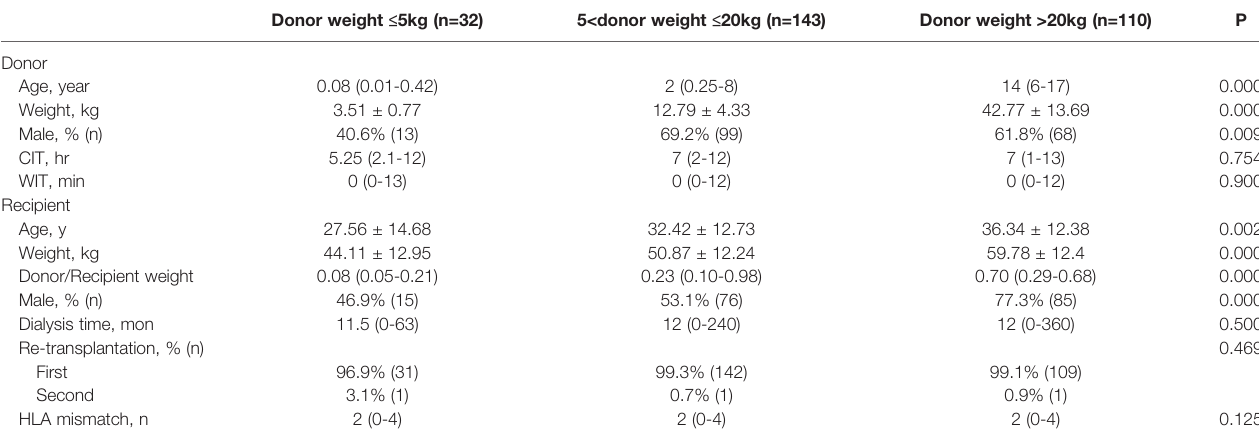
TABLE 1 | Donor and recipient